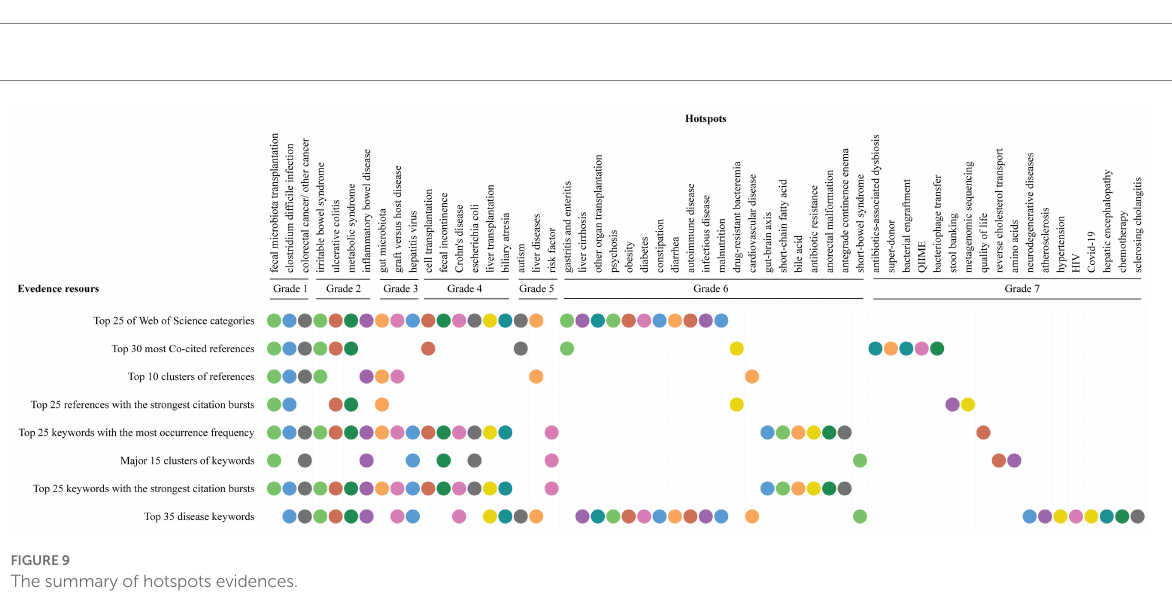
FIGURE 8 Keyword co-occurrence analysis. (A) The top 15 clusters of keywords. Each cross represents a keyword, and crosses with the same colors represent a cluster with the same topic. (B) The top 25 keywords with the strongest citation bursts. The “Strength” represents the strength of citation bursts, the strength value is proportional to the bursts. It also represents the important value of the keyword.